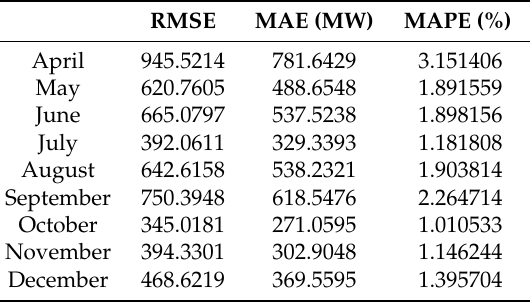
Table A1. Forecast accuracy measures root mean square error (RMSE), mean absolute error (MAE) and mean absolute percentage error (MAPE) for the forecasts of April to December